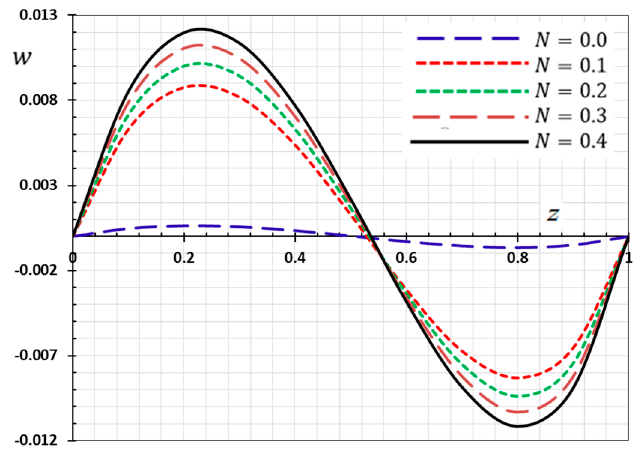
Figure 10. Variation of displacement 𝑤 versus 𝑧 for different gradient coefficient 𝑁 . Materials 2020 , 13 , x FOR PEER REVIEW